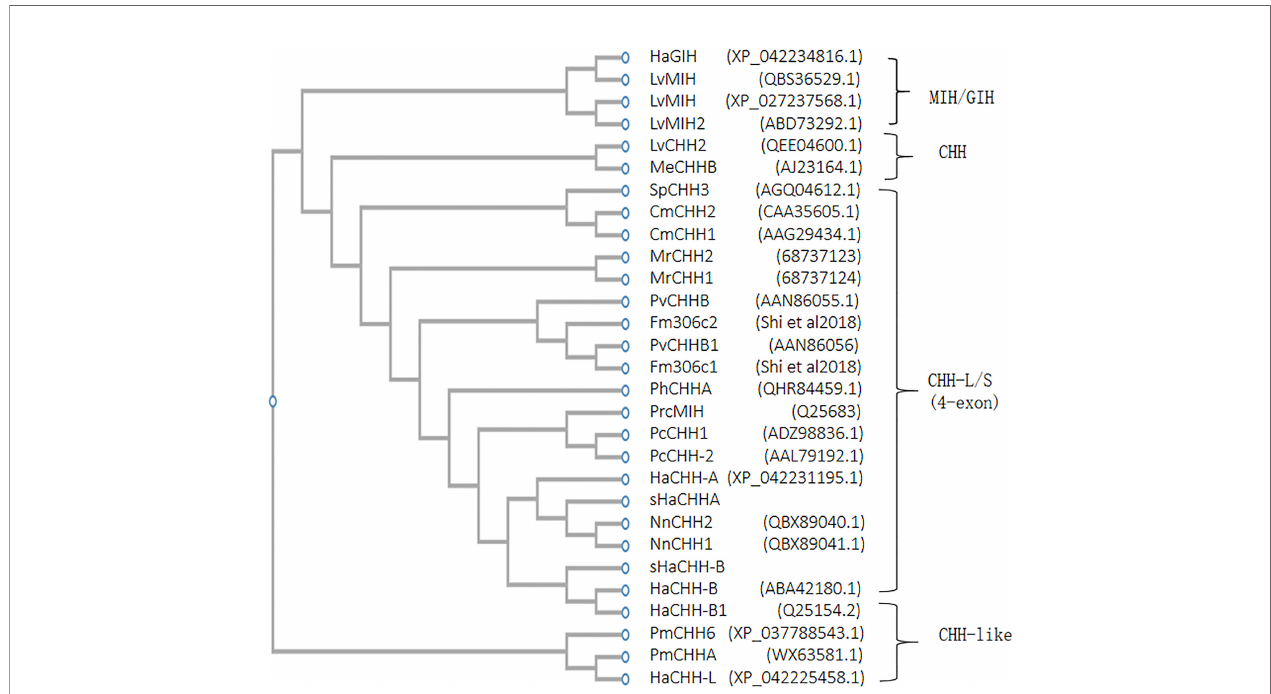
FIGURE 5 | Phylogenetic tree analysis of lobster HaCHH-A and HaCHH-B cDNA within the major subfamilies of decapod CHH/MIH/GIH. The sequences included the lobster ( Homarus americanus , Ha ) PhCHH-A (QHR84459.1), HaCHH-L (XP_042225458.1), HaGIH (XP_042234816.1), HaCHH-A (XP_042231195.1), sHaCHH- A, NnCHH2 (QBX89040.1), NnCHH1 (QBX89041.1), sHaCHH-B, (ABA42180.1), and HaCHH-B1 (Q25154.2); crab ( Carcinus maenas , Cm ) CmCHH2 (CAA35605.1), CmCHH1 (AAG29434.1), and SpCHH3 (AGQ04612.1); shrimp ( Litopenaeus vannamei , Lv ) LvMIH (QBS36529.1), LvMIH (XP_027237568.1), LvMIH2 (ABD73292.1), LvCHH2 (QEE04600.1), PvCHHB (AAN86055.1), Fm306c2 (Shi et al., 2018), PvCHHB1 (AAN86056), Fm306c1 (Shi et al., 2018), PmCHH6 (XP_037788543.1) PmCHHA (WX63581.1), and MeCHHB (AJ23164.1); freshwater shrimp ( Macrobrachium rosenbergii , Mr ) MrCHH2 (68737123) and MrCHH1(68737124); and cray fi sh ( Procambarus clarkii , Prc ) PrcMIH (Q25683), PcCHH1 (ADZ98836.1), and PcCHH-2 (AAL79192.1). GenBank accession numbers are shown in parentheses